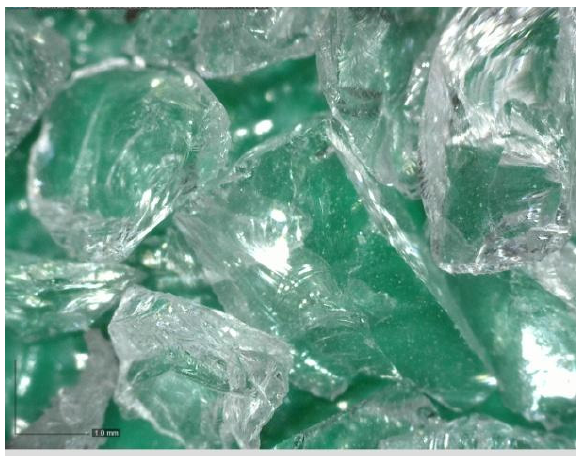
Figure 3. Glass recyclate fraction 1/4 mm; 51× magnified.